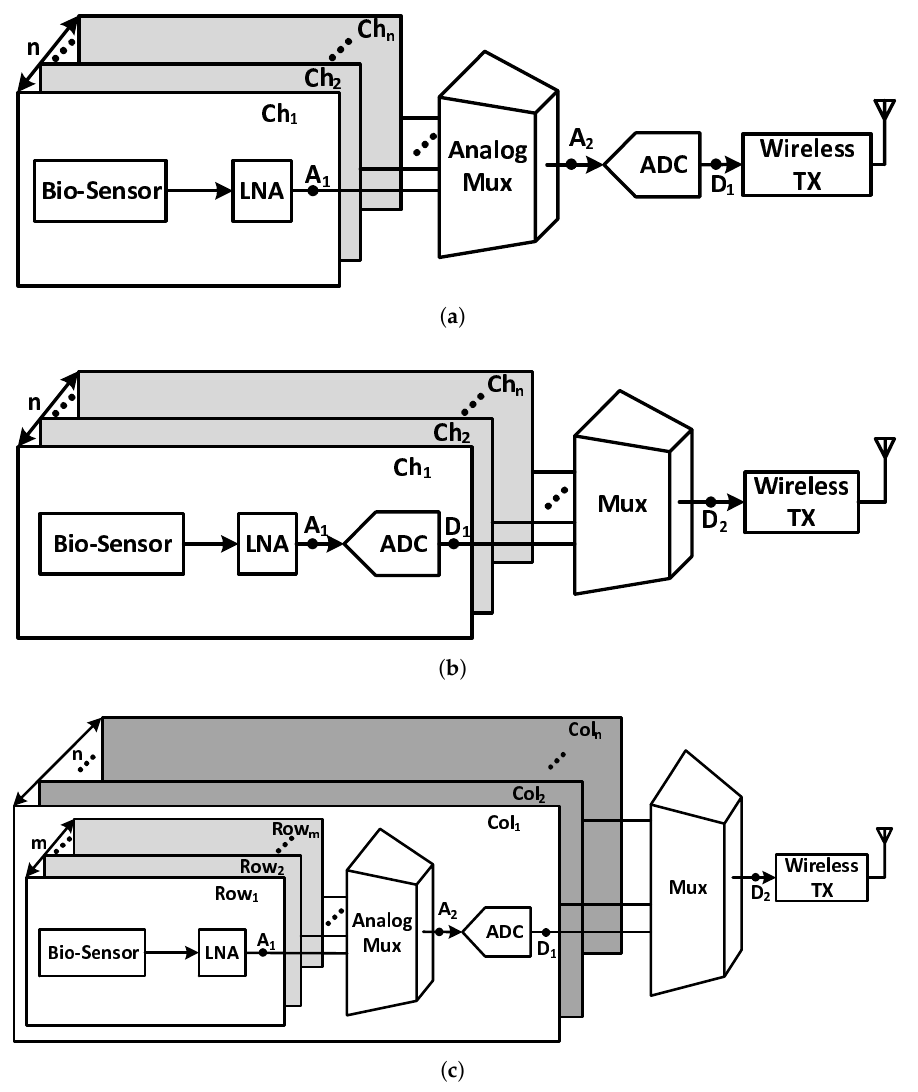
Figure 1. Block diagram of different multi-channel neural recording architectures. ( a ) This architecture shares an analog to digital converter (ADC) among all of the channels. ( b ) This architecture utilizes an ADC for each channel. ( c ) This architecture shares an ADC at each